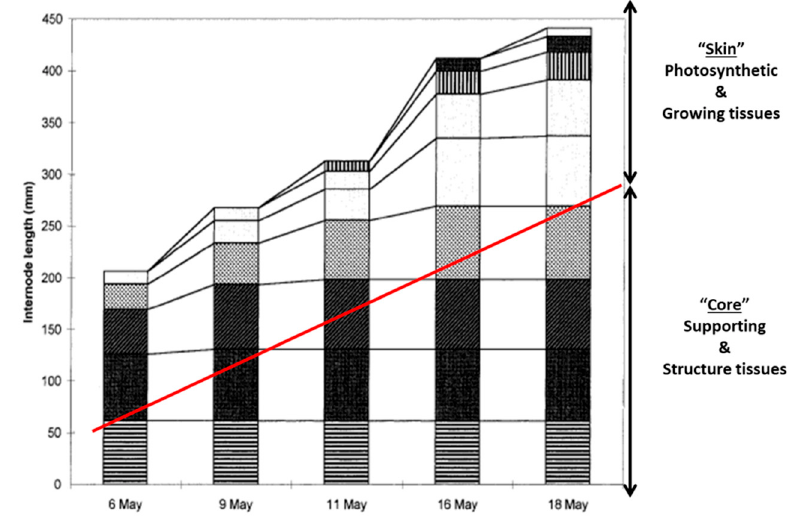
Figure 12. Evolution of the structure of an alfalfa stand during a spring growth period showing the length of the successive internodes on the dominant stems. As the digestibility of each internode and the N concentration in its associated leaf area is determined by its relative position within canopy layers, it is then possible to represent the whole canopy as being consisting of a more or less constant “Skin”, an upper envelope of young growing internodes and their well-illuminated leaves having high digestibility and a high N concentration, and an increasing “Core”, consisting of maturing stem internodes having a decreasing digestibility associated with shaded and senescing leaves with a low N concentration. Adapted from Vallet et al. [45].